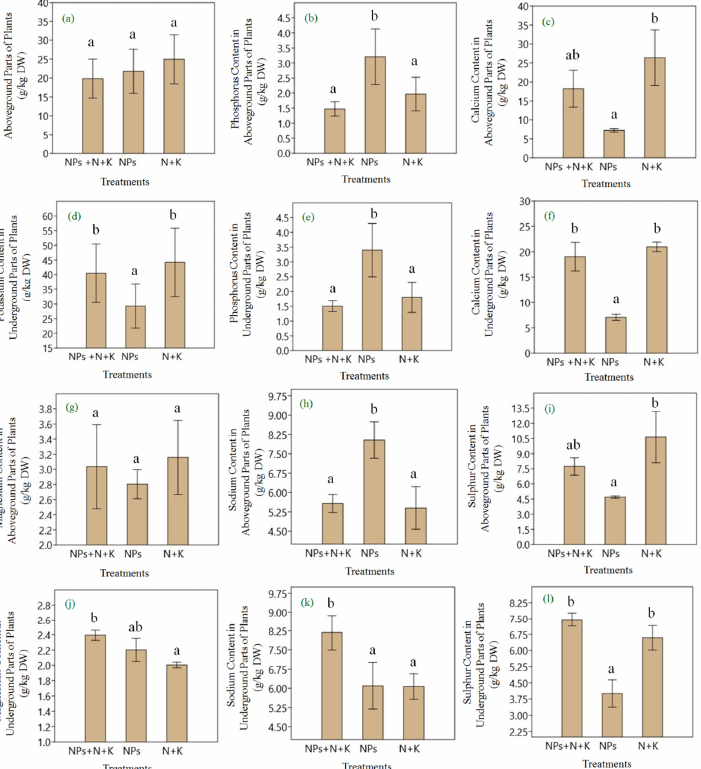
Figure 5. The ration effects of biochar nanoparticles, nitrogen, and potassium on Chinese cabbage of K ( a , d ), P ( b , e ), Ca ( c , f ), Mg ( g , j ), Na ( h , k ), and S ( i , l ) content of plants. (Note, NPs+N+K: BNPs- N-K=1:2:2 (T?), NPs: BNPs-N-K=2:0:0 (T5), N+K: BNPs-N-K=0:2:2 (T6); BNPs, biochar nanoparticles; 1 unit means 0.5 g/L nutrient; Error bars indicate standard error of the mean; Different letters indi- cate the significant differences with p < 0.05.)